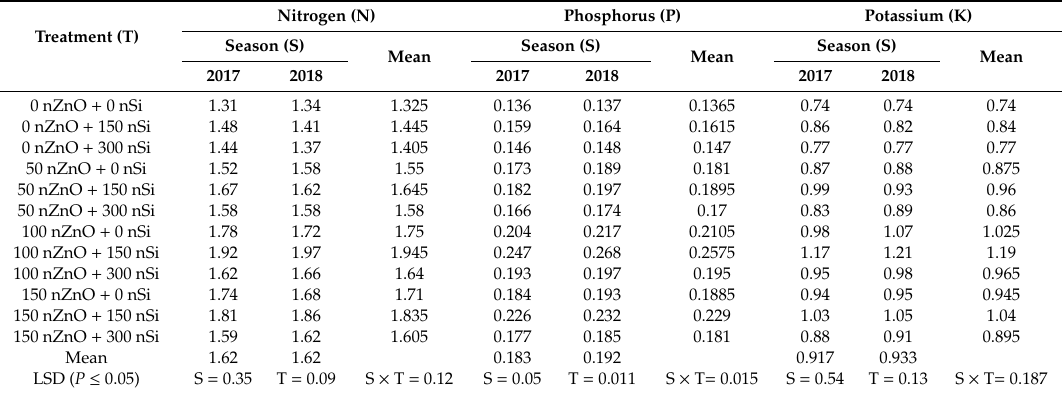
Table 3. E ff ect of foliar spray with ZnO and Si NPs (mg / L) on leaf NPK content (mg / g dw) of “Ewais” mango trees during the 2017 and 2018